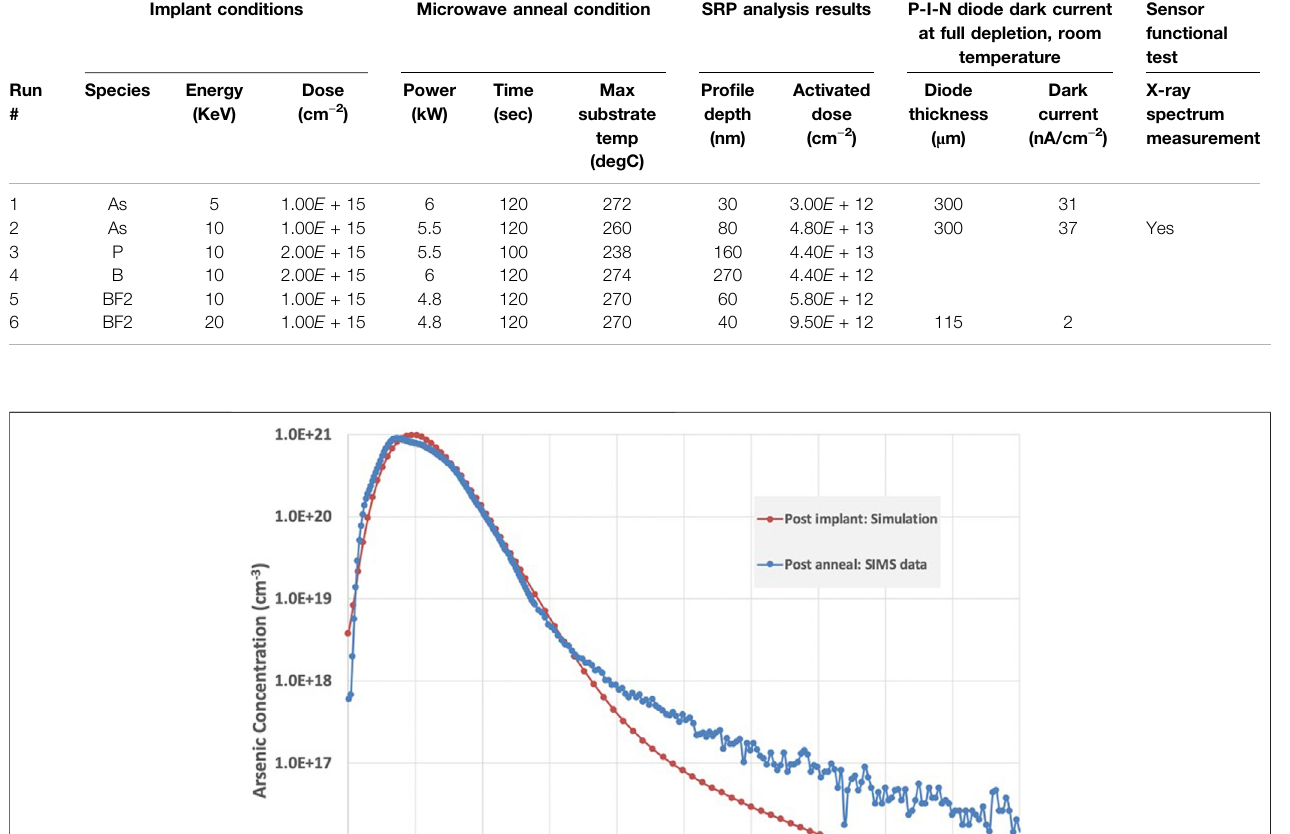
TABLE 1 | Microwave annealed dopant pro fi les results. Implant parameters and microwave anneal conditions for our experiments, with SRP results and, where available, dark current results. Implant conditions